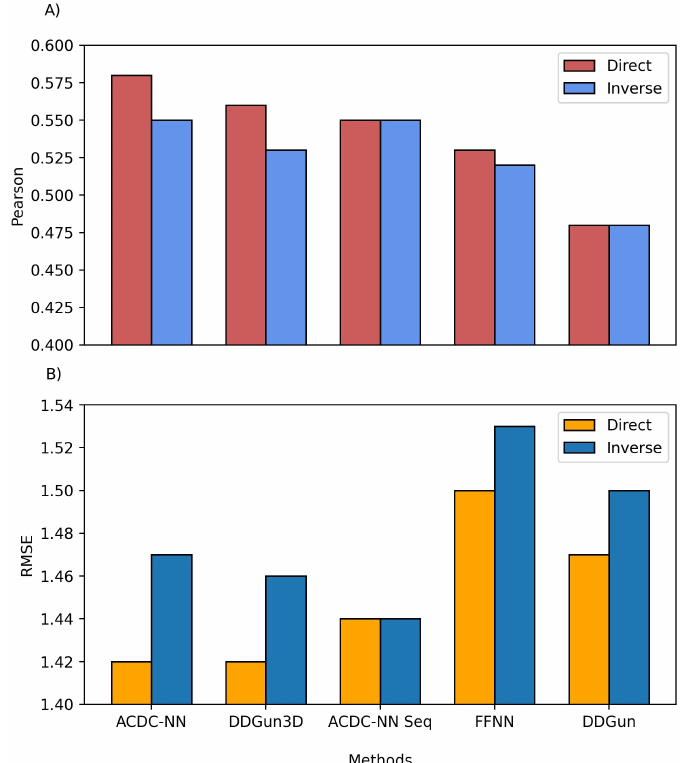
Figure 4. Comparison between the structure and sequence-based versions of ACDC-NN, DDGun and a Feed-Forward Neural Network (FFNN) on the Ssym dataset. ( A ) Pearson correlation coefficient ( r ), where higher is better and ( B ) root mean squared error (RMSE), where lower is better.